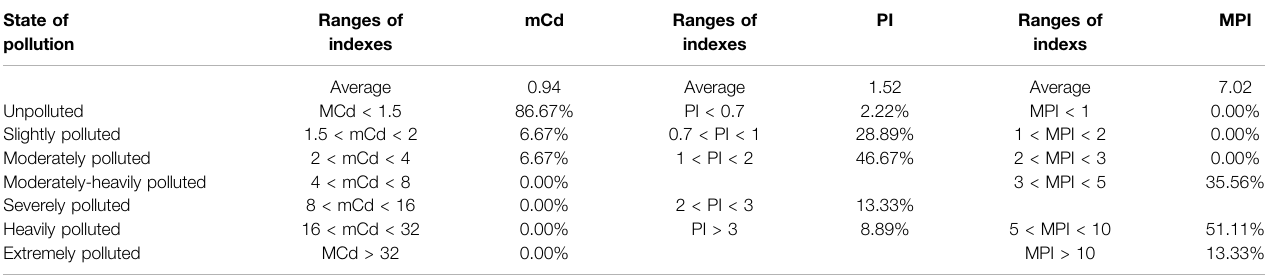
TABLE6| Variationsofevaluationresultsinthemodi fi eddegreeofcontamination(mCd),pollutionindex(PI),andmodi fi edpollutionindex(MPI)percentage(%)inthesurface sediments of the Jian and Moyang rivers. State of Ranges of pollution